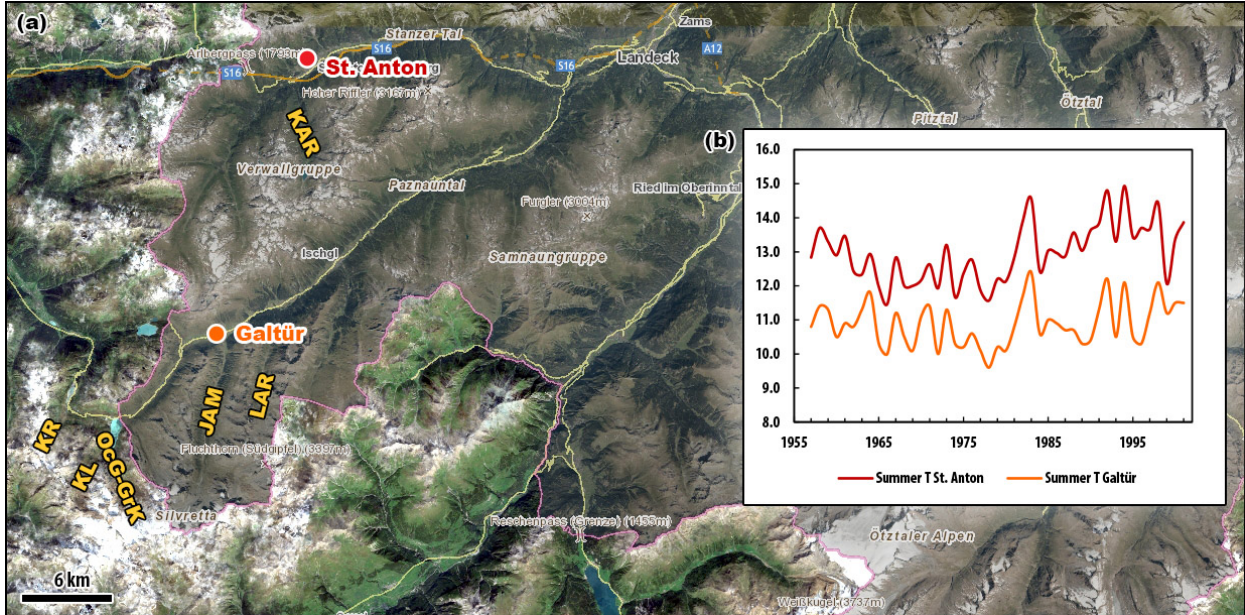
Figure B1. Overview of Silvretta and Verwall regions addressed in local correlation of moraine records (Sect. 5.2.1). (a) 10 Be moraine records generated in the following valleys: KAR is Kartell (Ivy-Ochs et al., 2006), KL is Klostertal, KR is Kromertal (Moran et al., 2016b), OcG-GrK is Ochsental/Grüne Kuppe (Braumann et al., 2020), JAM is Jamtal, and LAR is Laraintal (this study). Locations of meteorological stations in the Verwall region (St. Anton, station no. 14300) and in the Silvretta region (Galtür; homogenized HISTALP data) (Auer et al., 2007). Distance between the two stations amounts to approximately 20km. Orthophoto of 2020 provided by © Land Tirol (Land Tirol – tiris, 2020). (b) Summer (JJA) temperature time series (1957–2001) from the two stations that exhibit similar trends in the period between 1957–2001 (data provided by Austrian Weather Service